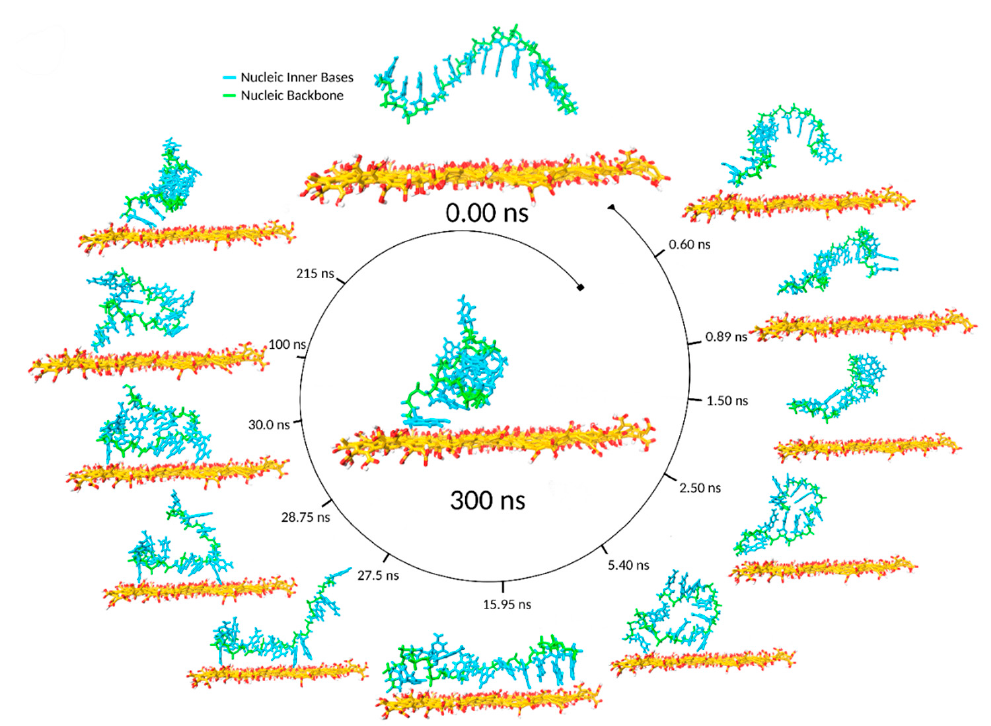
Figure 5. Trajectory snapshots ranging from 0 to 300 ns of ssDNA and GO in the presence of both Mg 2+ and Cl − atoms (ions not shown).